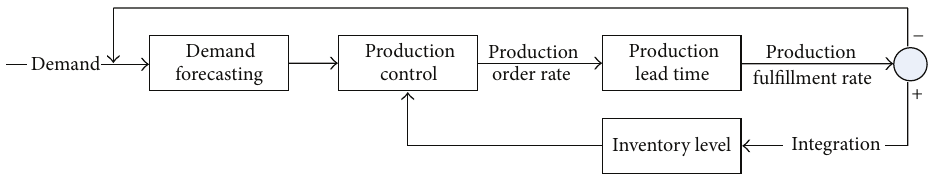
Figure 1: IOBPCS model of production and inventory system.